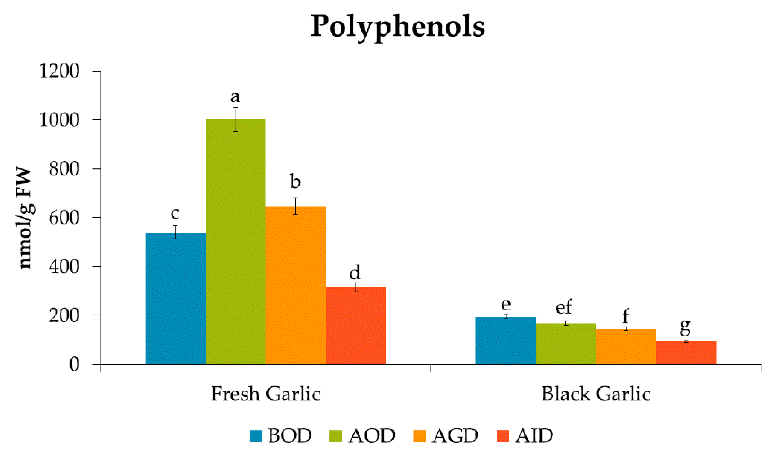
Figure 2. Quantities of total polyphenols during the in vitro gastrointestinal digestion. Data are expressed as nmol / g FW as mean values ( n = 6). Di ff erent letters (one-way ANOVA) denote statistically significant di ff erences between the stages of simulated gastrointestinal digestion ( p -value < 0.05). (BOD, Before Oral Digestion; AOD, After Oral Digestion; AGD, After Gastric Digestion; AID, After intestinal digestion).